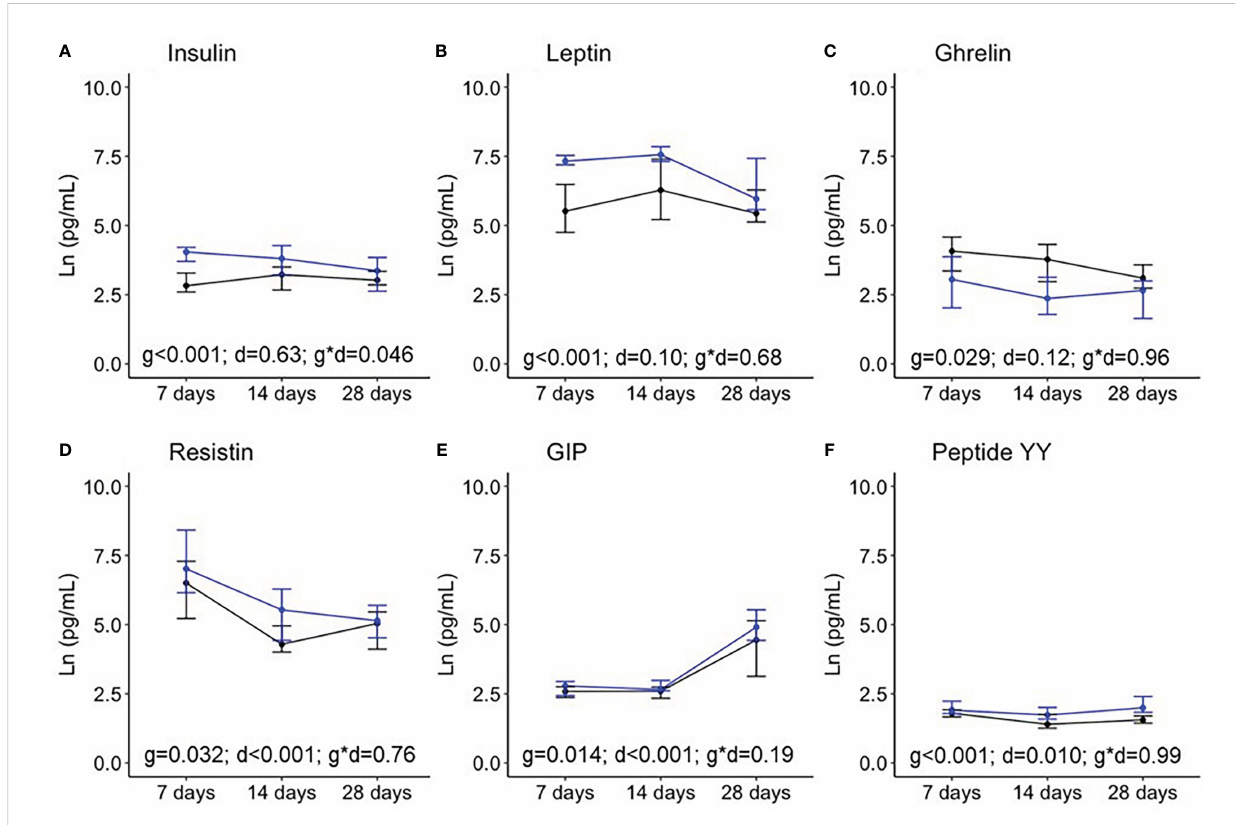
FIGURE 3 Breast milk levels of insulin (A) , leptin (B) , ghrelin (C) , resistin (D) , the gastrointestinal peptide (GIP); (E) , and peptide YY (F) during the fi rst month of lactation. Data show the median and interquartile range [Q1; Q3]. Black lines show term infants (7 days n = 20, 14 days n = 18, 28 days n = 17), and blue lines show preterm infants (7 days n = 13, 14 days n = 10, 28 days n = 10). In the two way-ANOVA, the following were considered as factors: preterm/term (group = g), birth/7days/14 days/28 days (day = d), and the interaction effect group and day (g *